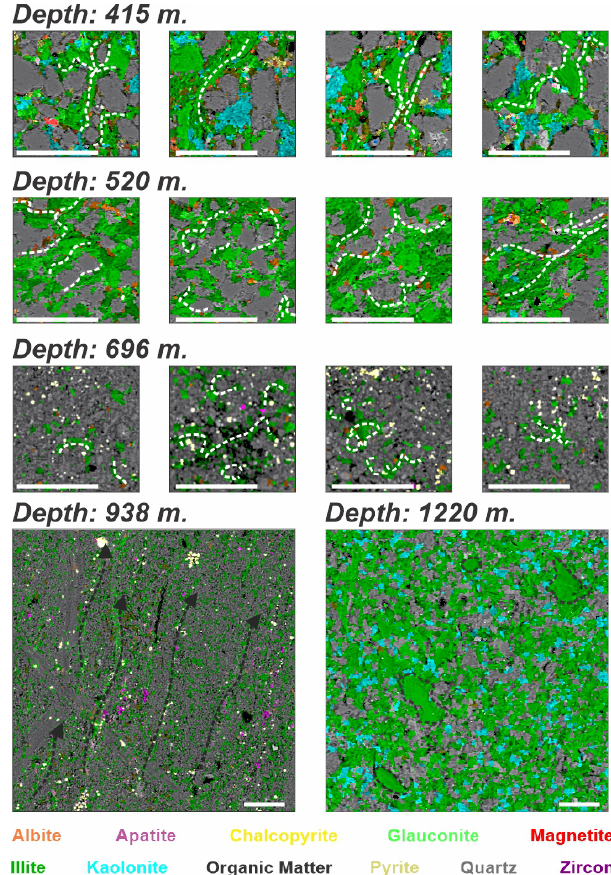
Figure 5. Spectral reflectance MLA maps of samples selected for in situ laser ablation analysis in this study overlain on top of their respective BSE images. Dashed white lines show illite assemblages wrapping around detrital grains and forming cements. Dashed black arrows show foliation in illite crystals. Dashed black lines show large illite crystals replacing previous clay assemblages. Solid white lines are 100µm scale